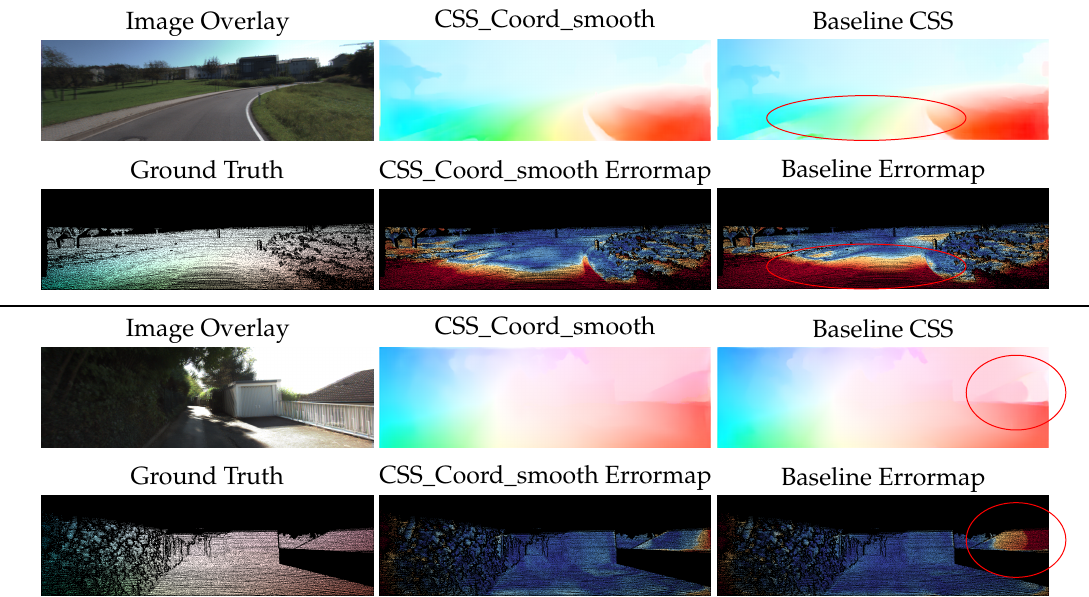
Figure 15. Qualitative results on the KITTI 2012 dataset. The network with our contributions produces more accurate, detailed, and smooth results than that of the baseline